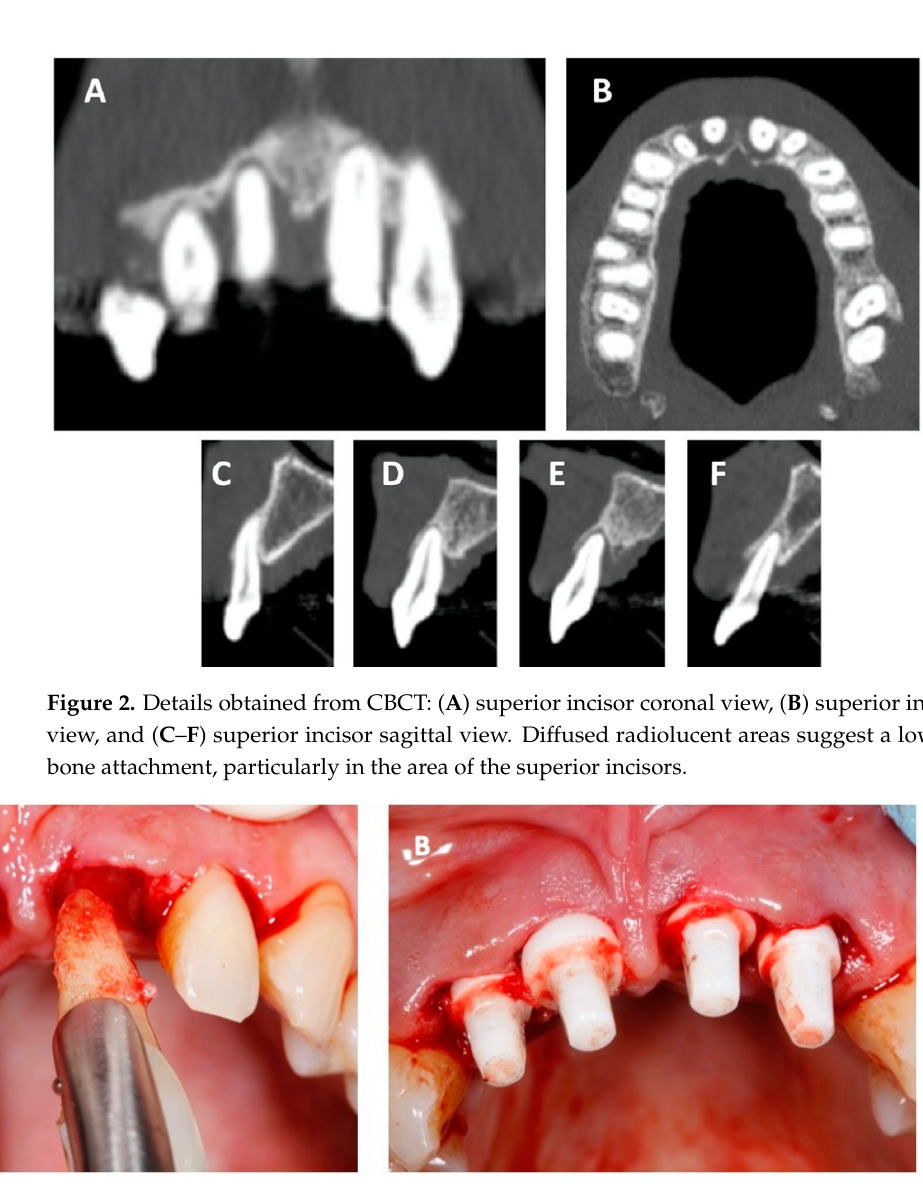
Figure 4. Pictures obtained six months after the operation, showing ( A ) a good state of osteointegration, no bleeding, and no active infection, with healthy periodontal tissue, and ( B ) dental radiography showing a good grade of osteointegration and no significant radiolucent areas. Fourteen months after the intervention, the periodontal soft tissues appeared healthy and with an optimal periodontal seal. The other teeth also showed less severe periodonti- tis, with improvements in CAL and BOP. The patient felt relieved from a physical and psychological perspective and reported no significant complications during the whole pe- riod. The prosthesis was then finalized with esthetic zirconia ceramic crowns (Figure 5).